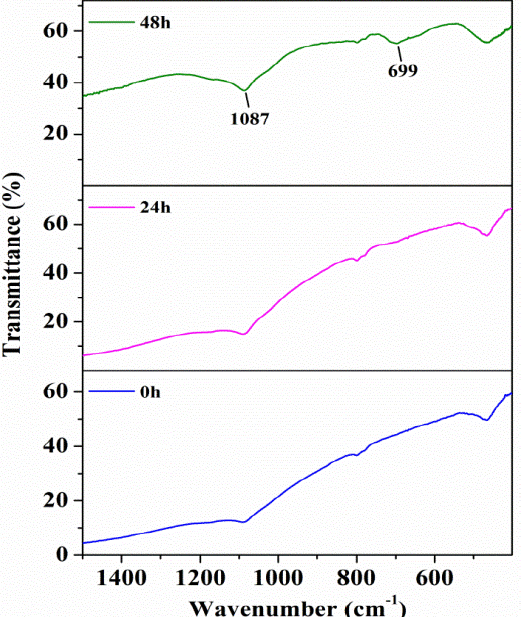
Figure 3. FTIR spectra of diamond/akageneite hybrid particles with different reaction durations.